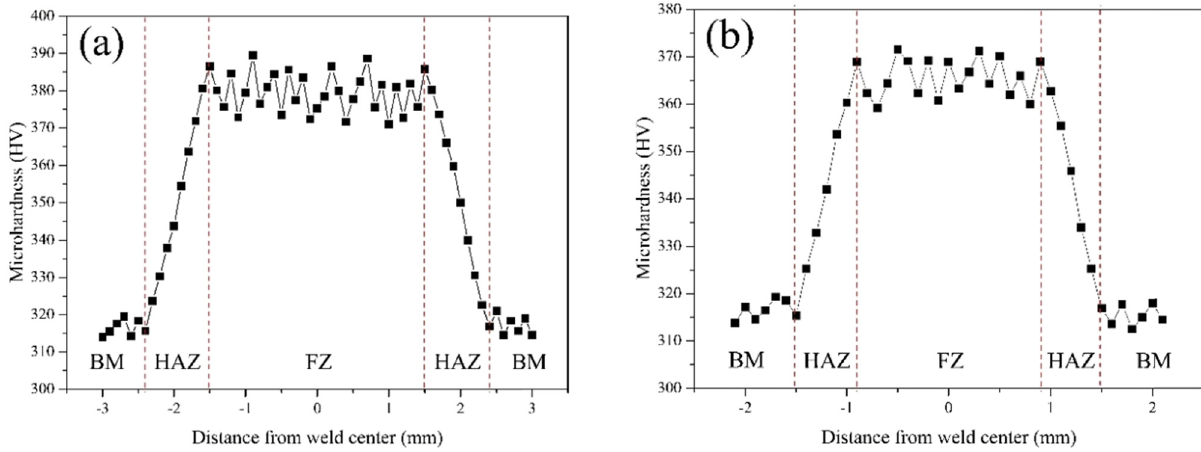
Figure 11: Microhardness distribution of weld zone: ( a ) EBW joint and ( b ) P - LBW joint.